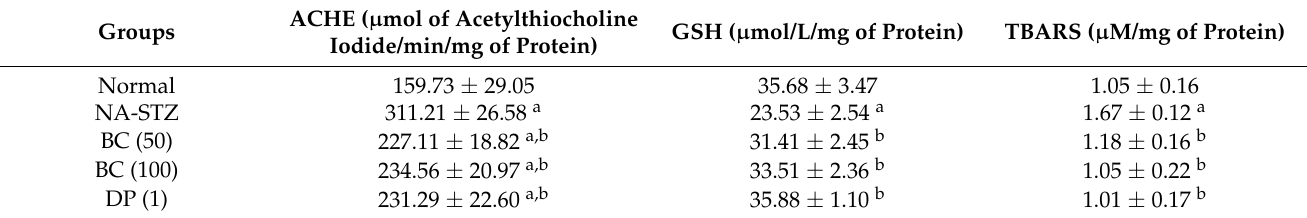
Table 1. Effect of BC on hippocampal